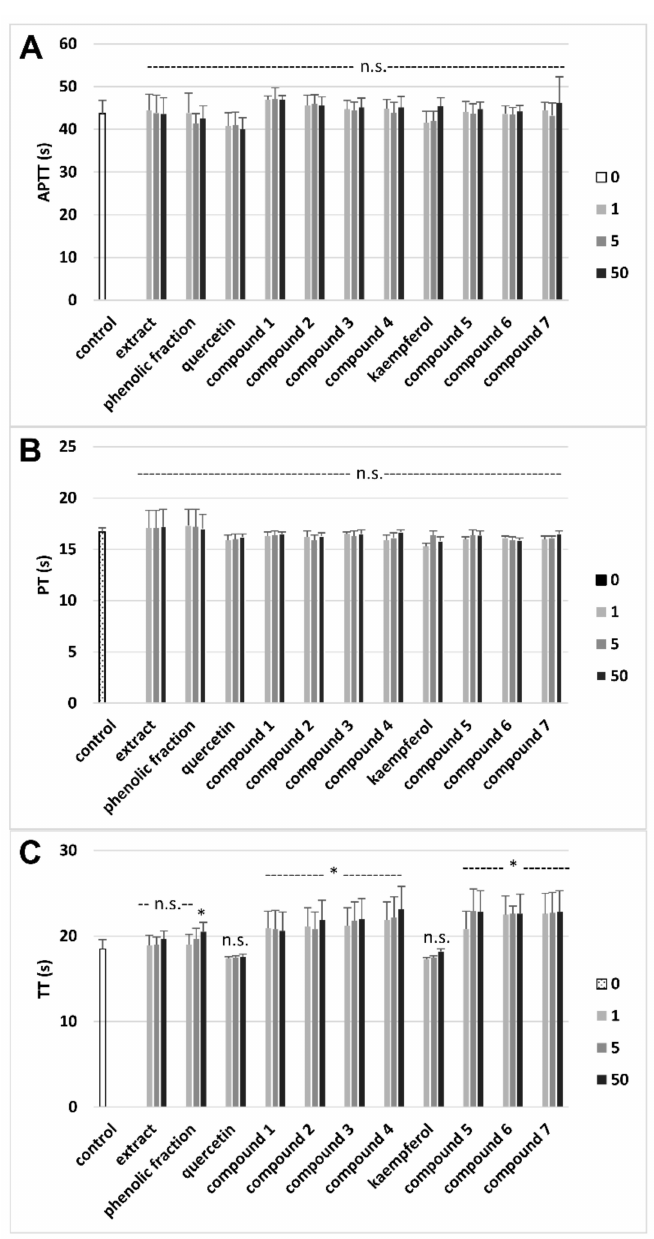
Figure 4. Effects of the crude extract, the phenolic fraction and flavonoids from lentil aerial parts (1–50 µ g/mL) and commercial flavonoids (quercetin and kaempferol) on selected hemostatic param- eters of plasma: the activated partial thromboplastin time (APTT) ( A ), the prothrombin time (PT) ( B ) and the thrombin time (TT) ( C ). Data represent means ± SD of 6 independent experiments. * p < 0.05 (vs. control), n.s. p > 0.05 (vs.